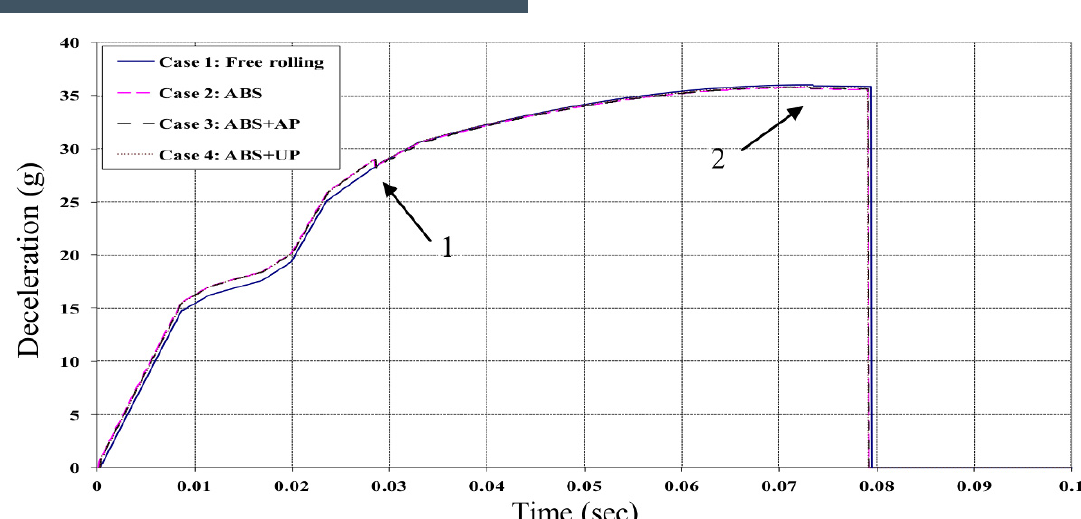
Figure 14. Deceleration of the vehicle body for all cases at full frontal collision and speed of 70 km/hr.